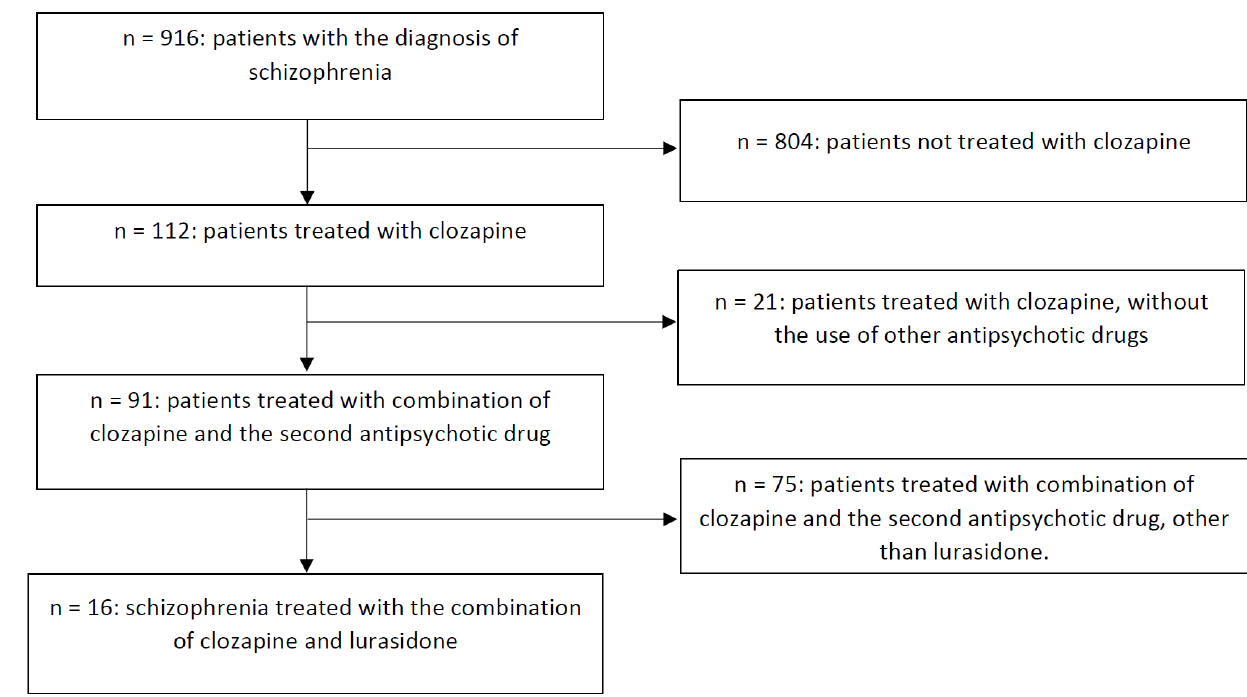
Figure 1. Flow chart of retrospective chart review.